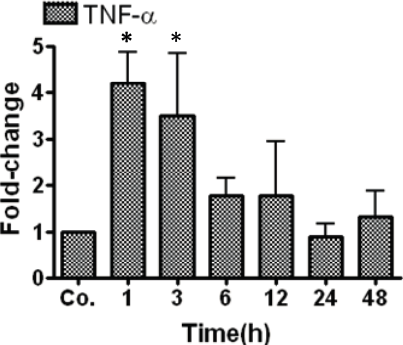
Figure 1. qRT-PCR analysis of total mRNA isolated from mice livers after